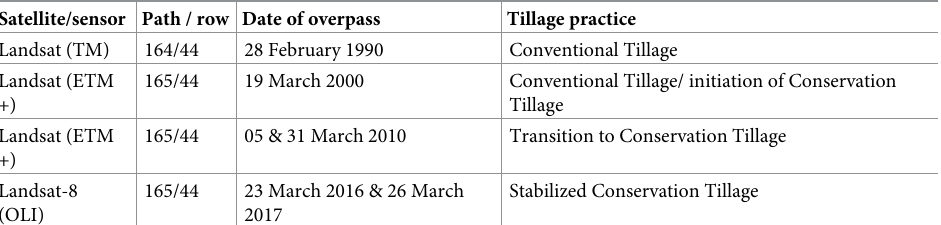
Table 3. Details of the sensors, the acquired images and the corresponding tillage practices. Satellite/sensor Path / row Date of